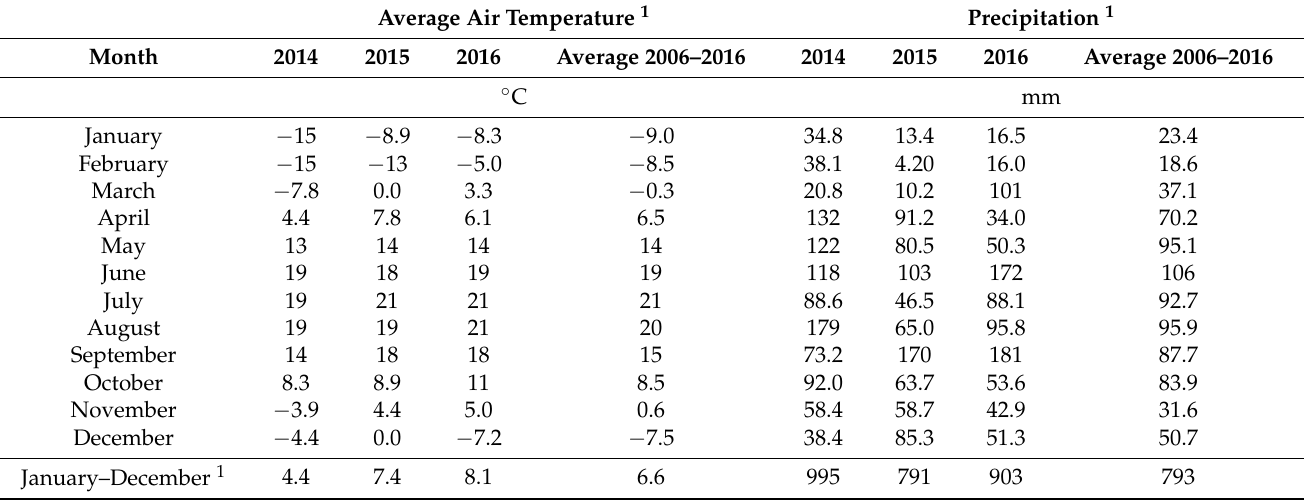
Table 1. Average air temperature and total precipitation by month